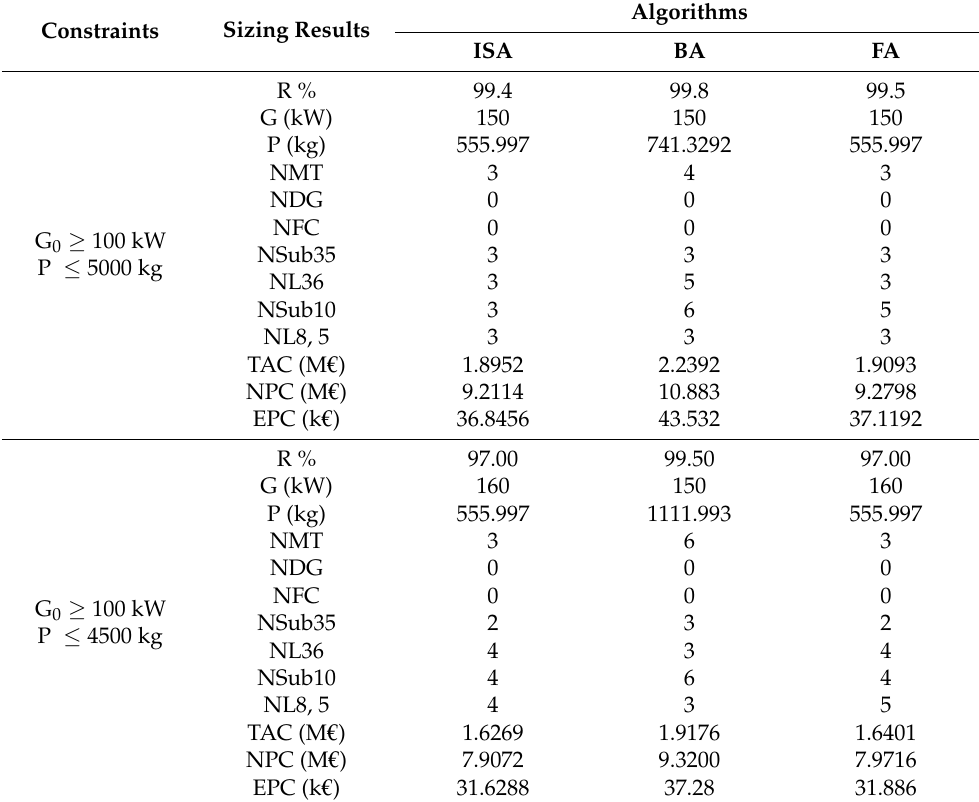
Table 9. Optimization results of the bi-objective function: minimize cost and minimize pollution.